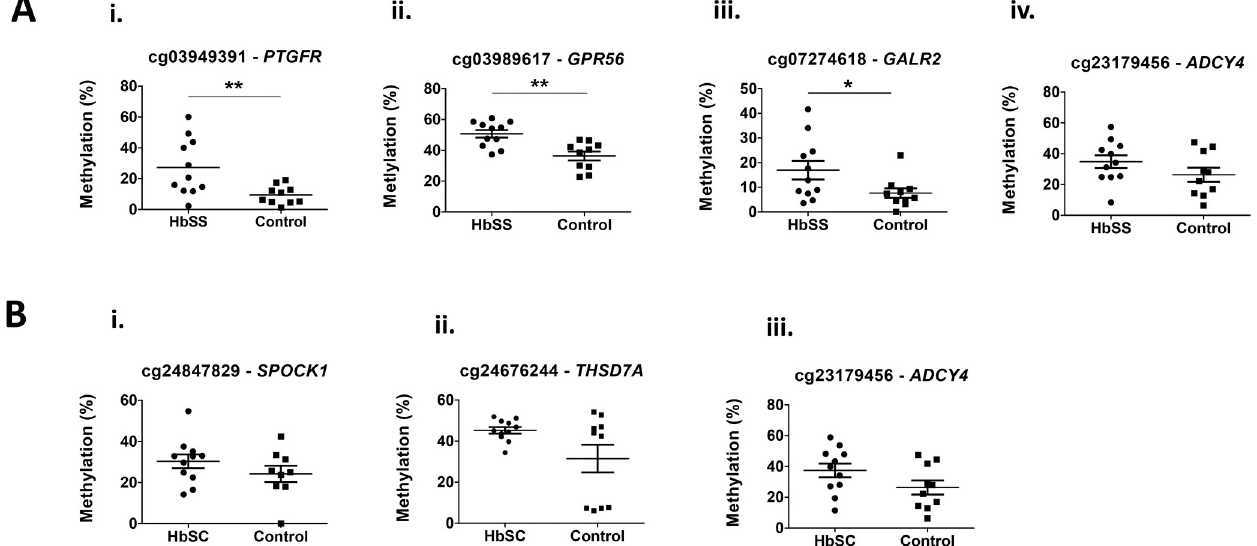
Fig 6. Methylation data from pyrosequencing analysis in the HbSS and HbSC groups compared with the control group (CON). A: CpGs sites analyzed in the HbSS group. i cg03949391-PTGFR; ii cg3989617-GPR56; iii cg0727418-GALR2 and iv cg23179456-ADCY4. B: CpGs sites analyzed in the HbSC group. i cg24847829-SPOCK1; ii cg24676244-THSD7A and iii cg23179456-ADCY. � p < 0.05, �� p < 0.01 (Student’s unpaired t